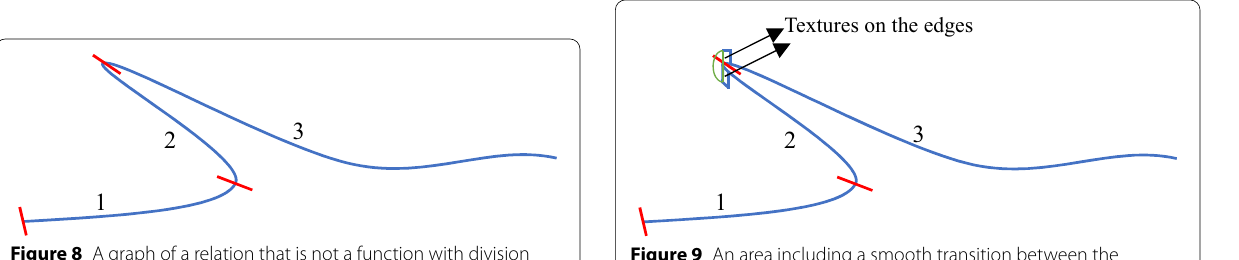
Figure 9 An area including a smooth transition between the adjacent sub-curves (sub-surfaces), enclosed in green boundary